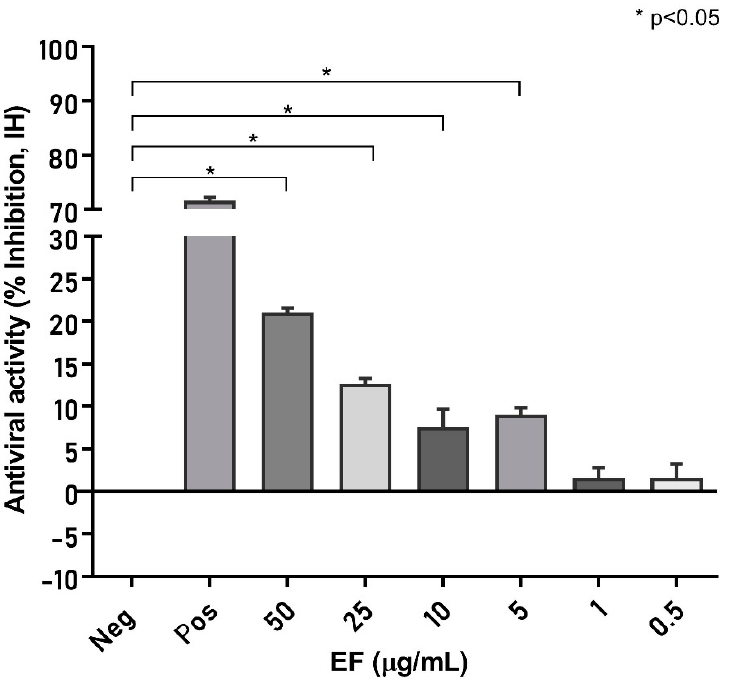
Figure 6. EF affects S protein binding to ACE2 receptor. S protein (RBD)-coated ELISA plates were incubated with increasing EF concentrations and subsequently the binding of biotinylated ACE2 receptors was quantified by measurement of chemiluminescence (% Inhibition, IH). As a positive control, ACE2 was co-incubated with immunized patient sera, which inhibited more than 71.5% of ACE2 receptor binding. EF at 50 µg/mL inhibited S protein binding, up to 21.0% to ACE2 ( p < 0.05).